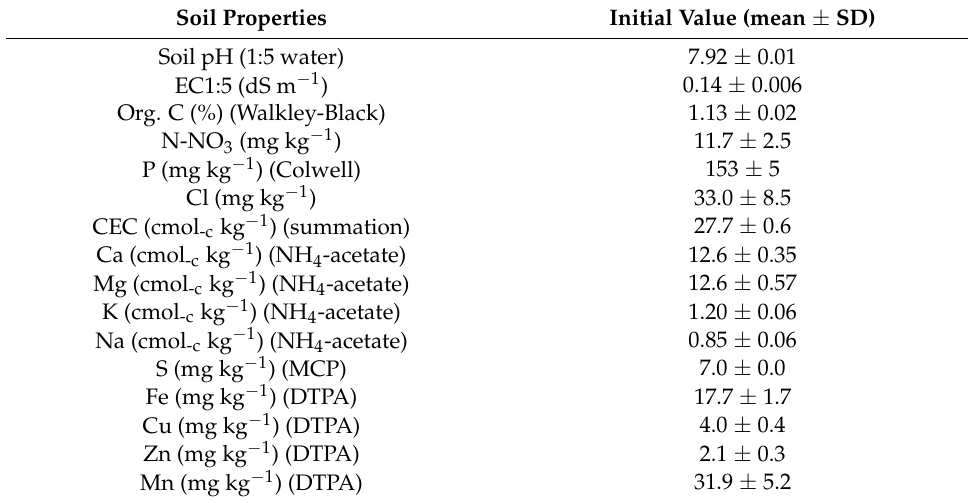
Table 3. Soil characteristics at the commencement of the field